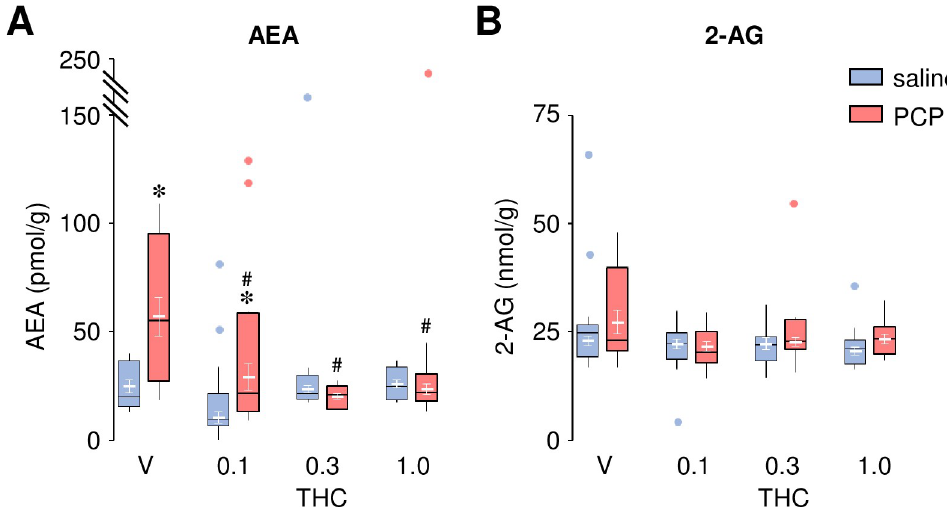
Fig 2. THC reversed PCP-induced increase in AEA levels in the nucleus accumbens. Effects of THC (0.1–1.0 mg/kg) on AEA ( A ) and 2-AG ( B ) levels in the nucleus accumbens of saline- and PCP- treated rats immediately after the motor activity task ( d -amphetamine-induced hyperactivity; see Fig 1E). The raw data for this figure are reported in the supplemental file (S1 Raw data) and are summarized here as boxplots computed using Carling’s modification [42]; outliers are depicted as blue (saline) or red (PCP) circles. Values (in white) are expressed as mean ± S.E.M. (n = 11–14 per group). � P < 0.05 compared to saline-treated controls, # P < 0.05 compared to vehicle (V) controls (Newman- Keuls post-hoc